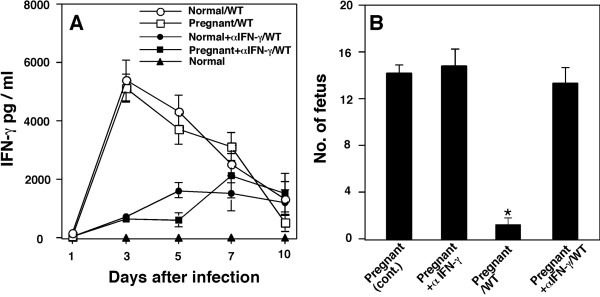
Preventing abortion by neutralizing IFN-γ. IFN-γ was neutralized in mice by administering anti-mouse IFN-γ monoclonal antibody (clone HB170) in vivo using 1 mg of antibody in a volume of 0.5 ml intraperitoneally 24 h before infection. Control mice were given 1 mg of normal rat IgG in 0.5 ml according to the same injection schedule as the corresponding anti-IFN-γ monoclonal antibody treatment groups. (A) IFN-γ in serum measured by ELISA. The mean and SE for groups of five mice are shown (B) Number of fetuses. Statistically significant differences between the untreated control and antibody treated mice are indicated by asterisks (*, P < 0.01).